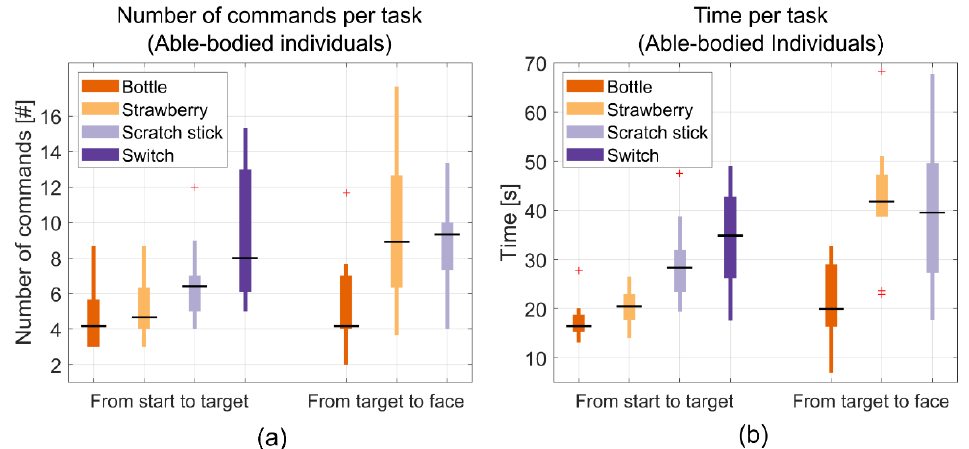
Figure 10. Boxplots of the mean performance metrics for able-bodied individuals. The two groupings in each plot show the results the reaching phase and the moving object phase, respectively, and each column corresponds to each task: bottle, strawberry, scratch stick, and switch, respectively. ( a ) Shows the number of commands used during each phase of the task while ( b ) shows the time it took to complete each phase of each task.